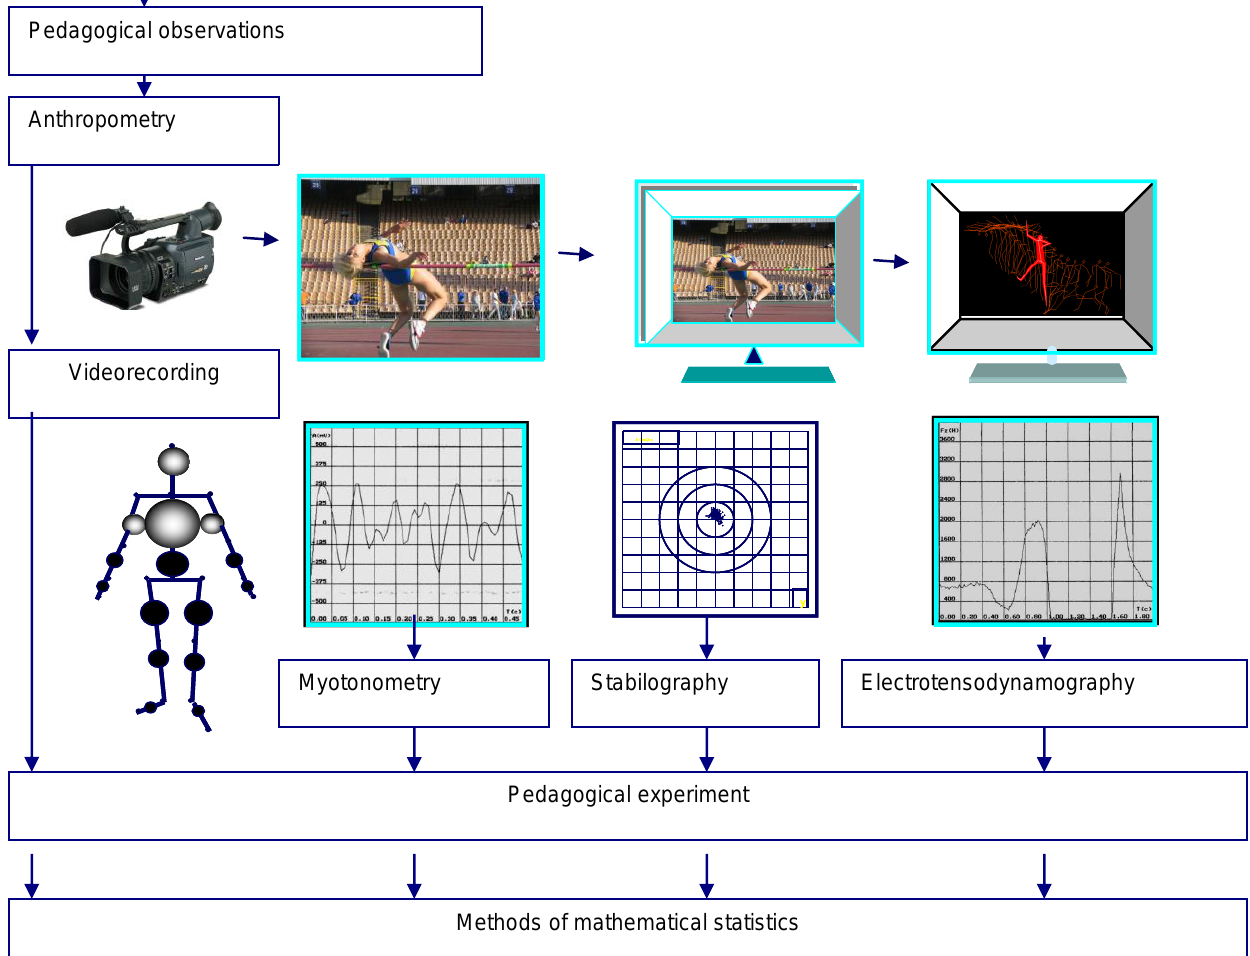
Fig. 1. Algorithm of studying technical skills of track and field